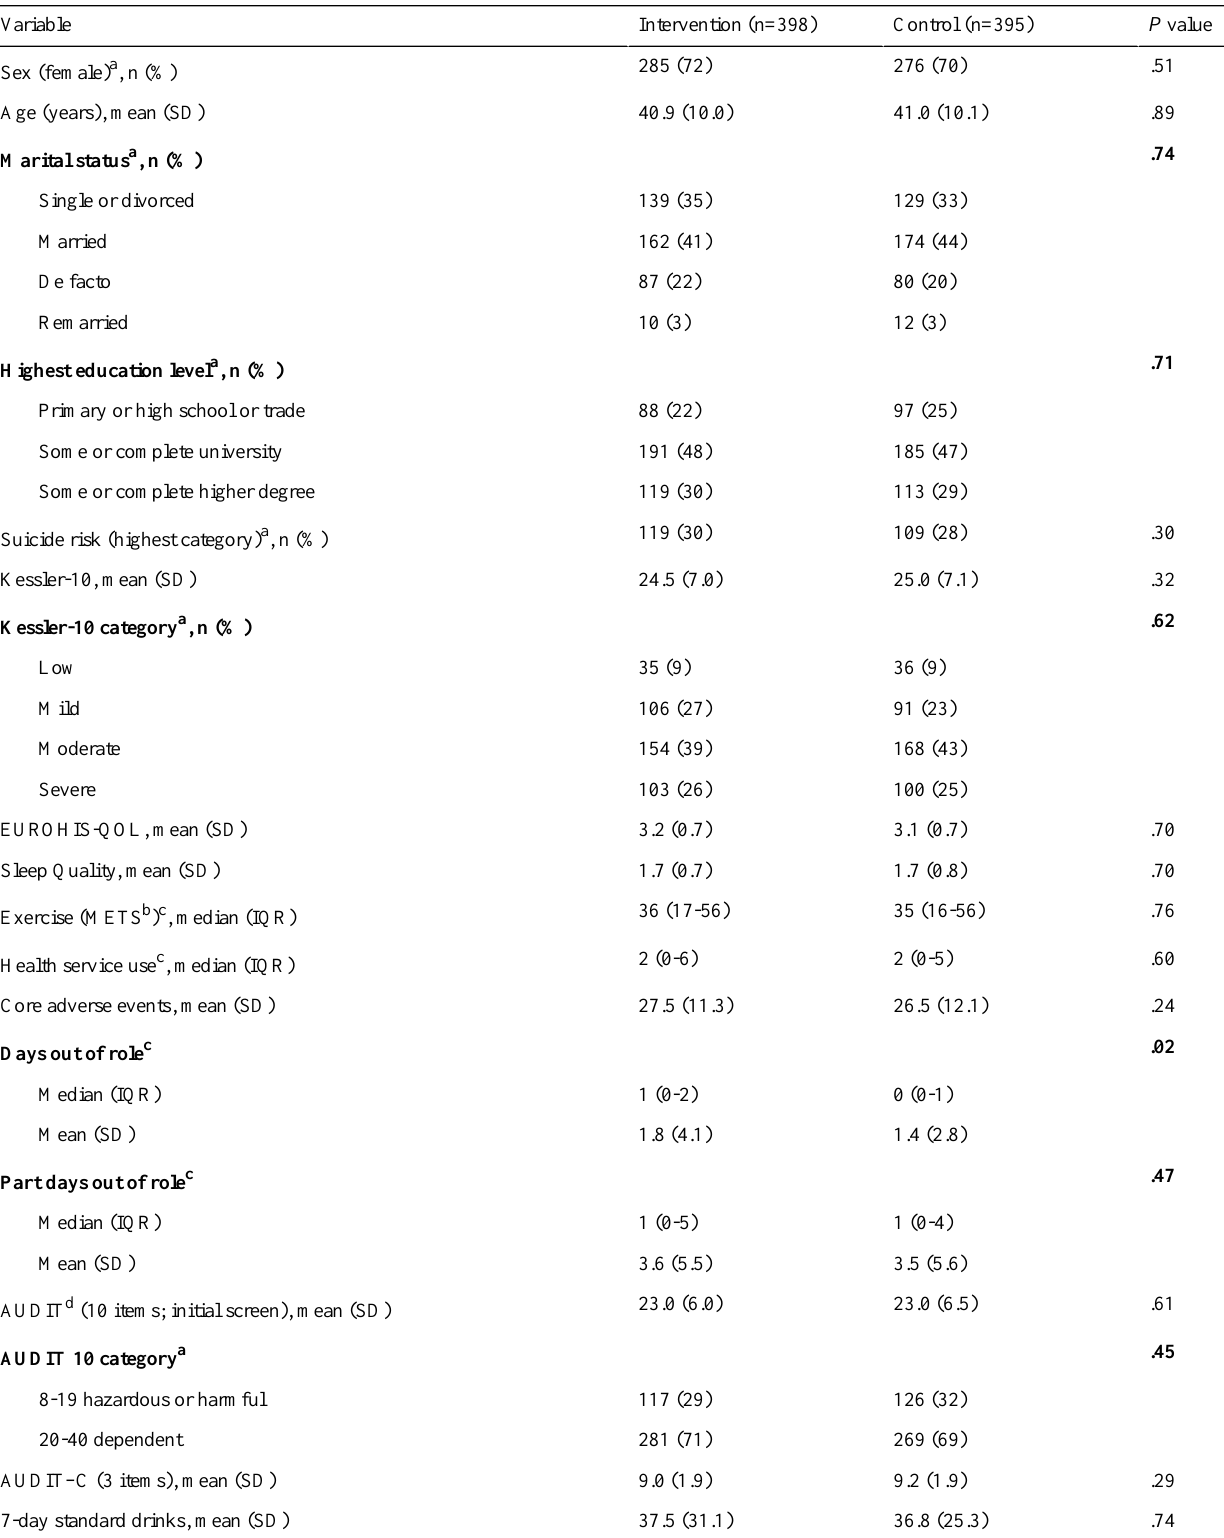
Table 1. Baseline characteristics